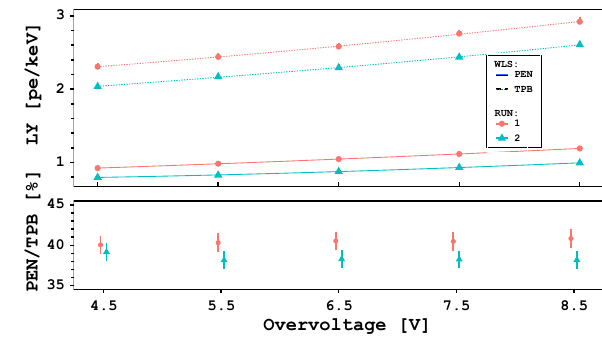
Fig. 5 241 Am data (red) and environment data (blue) in the detectors with TPB and PEN, acquired at an over-voltage of 6.5 V